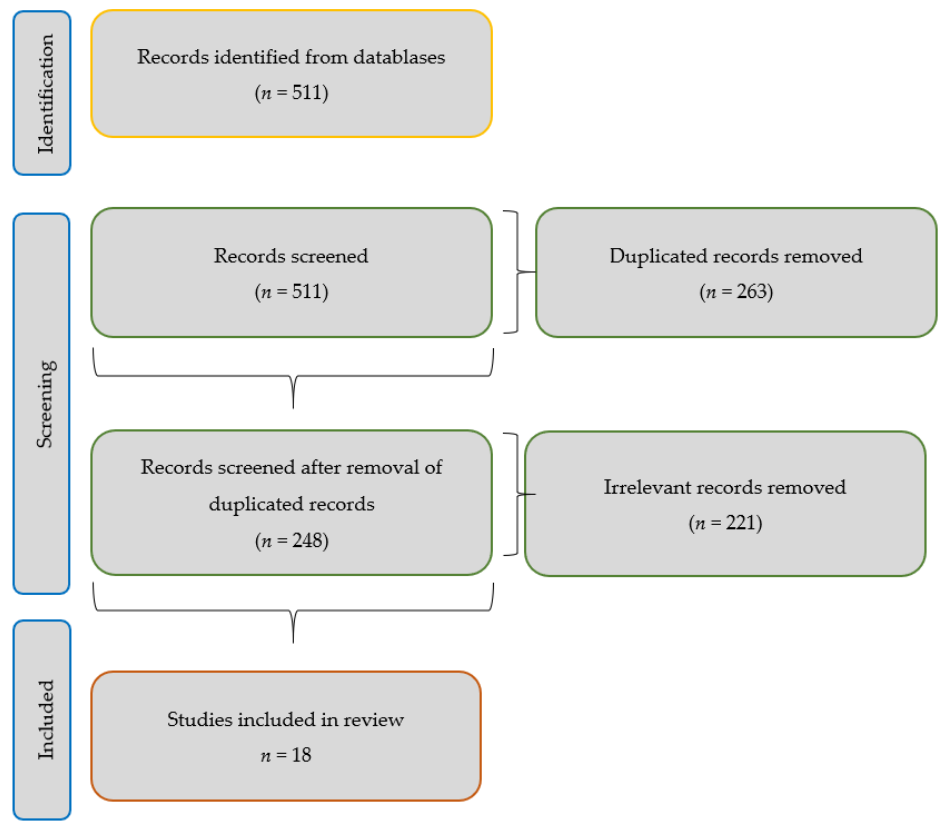
Figure 1. Flow Figure 1. Flow diagram.